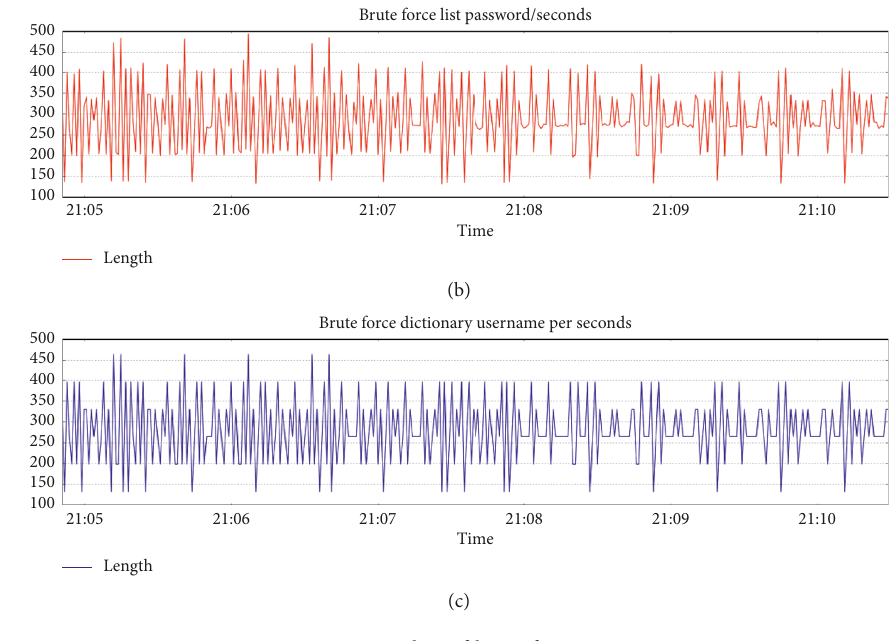
Figure 11: Snapshot of brute force attempts.